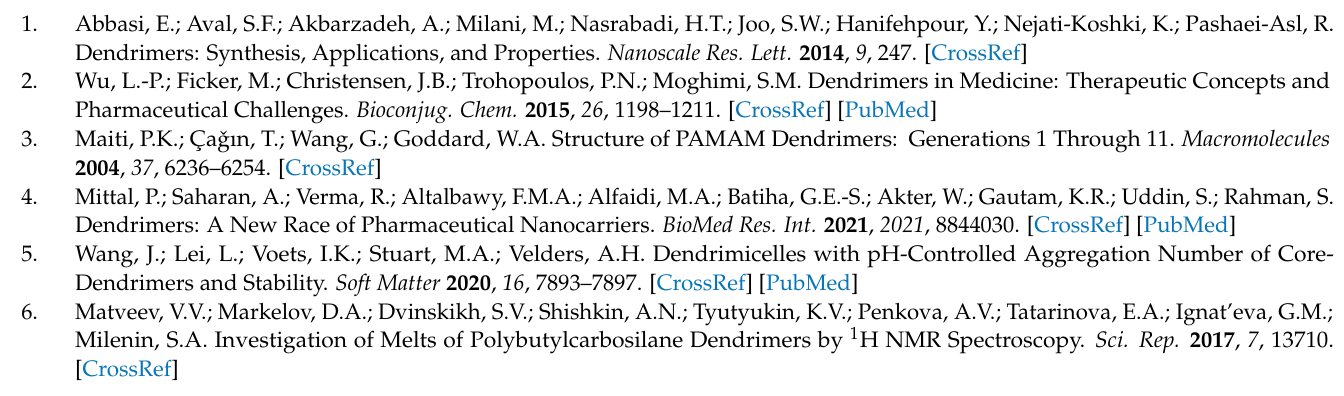
hydroxyphenethyl)carbamate. Figure S2. 13 C-NMR spectrum of tert -butyl (4-hydroxyphenethyl)carbamate. Figure S3. IR spectrum of tert -butyl (4-hydroxyphenethyl)carbamate. Figure S4. DART tert -butyl (4- hydroxyphenethyl)carbamate. Figure S5. 1 H-NMR spectrum of tert -butyl (4-(prop-2-yn-1-yloxy)phenyl) carbamate. Figure S6. 13 C-NMR spectrum of tert -butyl (4-(prop-2-yn-1-yloxy)phenyl)carbamate. Figure S7. IR spectrum of tert -butyl (4-(prop-2-yn-1-yloxy)phenyl)carbamate. Figure S8. DART spectrum of tert -butyl (4-(prop-2-yn-1-yloxy)phenyl)carbamate. Figure S9. 1 H-NMR spectrum of 2-(4-(prop-2-yn-1-yloxy)phenyl)ethan-1-amine. Figure S10. 13 C-NMR spectrum of 2-(4-(prop-2-yn- 1-yloxy)phenyl)ethan-1-amine. Figure S11. IR spectrum of 2-(4-(prop-2-yn-1-yloxy)phenyl)ethan-1- amine. Figure S12. DART spectrum of 2-(4-(prop-2-yn-1-yloxy)phenyl)ethan-1-amine. Figure S13. 1 H-NMR spectrum of disubstituted EDTA alkyne. Figure S14. 13 C-NMR spectrum of disubstituted EDTA alkyne. Figure S15. IR spectrum of disubstituted EDTA alkyne. Figure S16. ESI spectrum of disubstituted EDTA alkyne. Figure S17. 1 H-NMR spectrum of tetrasubstituted EDTA G0-alkyne. Figure S18. 13 C-NMR spectrum of tetrasubstituted EDTA G0-alkyne. Figure S19. IR spectrum of tetrasubstituted EDTA G0-alkyne. Figure S20. ESI spectrum of tetrasubstituted EDTA G0-alkyne. Figure S21. 1 H-NMR spectrum of dendritic EDTA di- β CD. Figure S22. 13 C-NMR spectrum of den- dritic EDTA di- β CD. Figure S23. 2D NMR HMQC spectrum of dendritic EDTA di- β CD. Figure S24. 2D NMR COSY spectrum of dendritic EDTA di- β CD. Figure S25. IR spectrum of dendritic EDTA di- β CD. Figure S26. ESI-TOF spectrum of dendritic EDTA di- β CD. Figure S27. 1 H-NMR spectrum of EDTA G0- β CD dendrimer. Figure S28. 13 C-NMR spectrum of EDTA G0- β CD dendrimer. Figure S29. 2D NMR COSY spectrum of EDTA G0- β CD dendrimer. Figure S30. IR spectrum of EDTA G0- β CD dendrimer. Figure S31. MALDI-TOF spectrum of EDTA G0- β CD